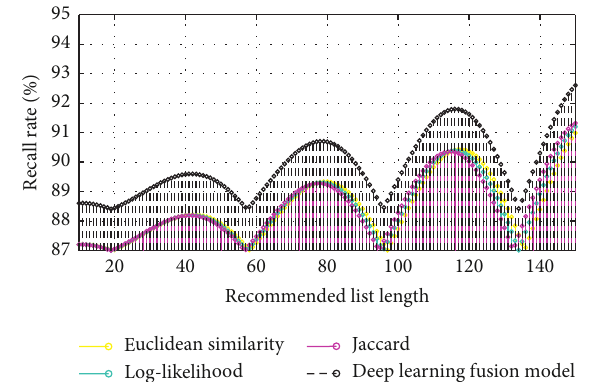
Figure 7: Comparison of predicted recall rate under different recommended N values of Top- N